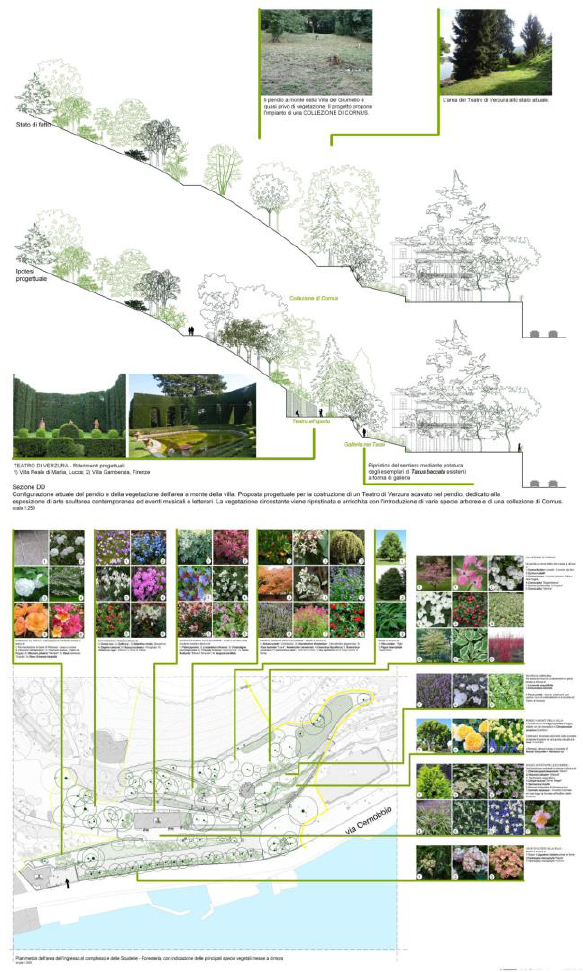
Figure 6. Conservation intervention on the former stables area of the Villa del Grumello historic garden on Como